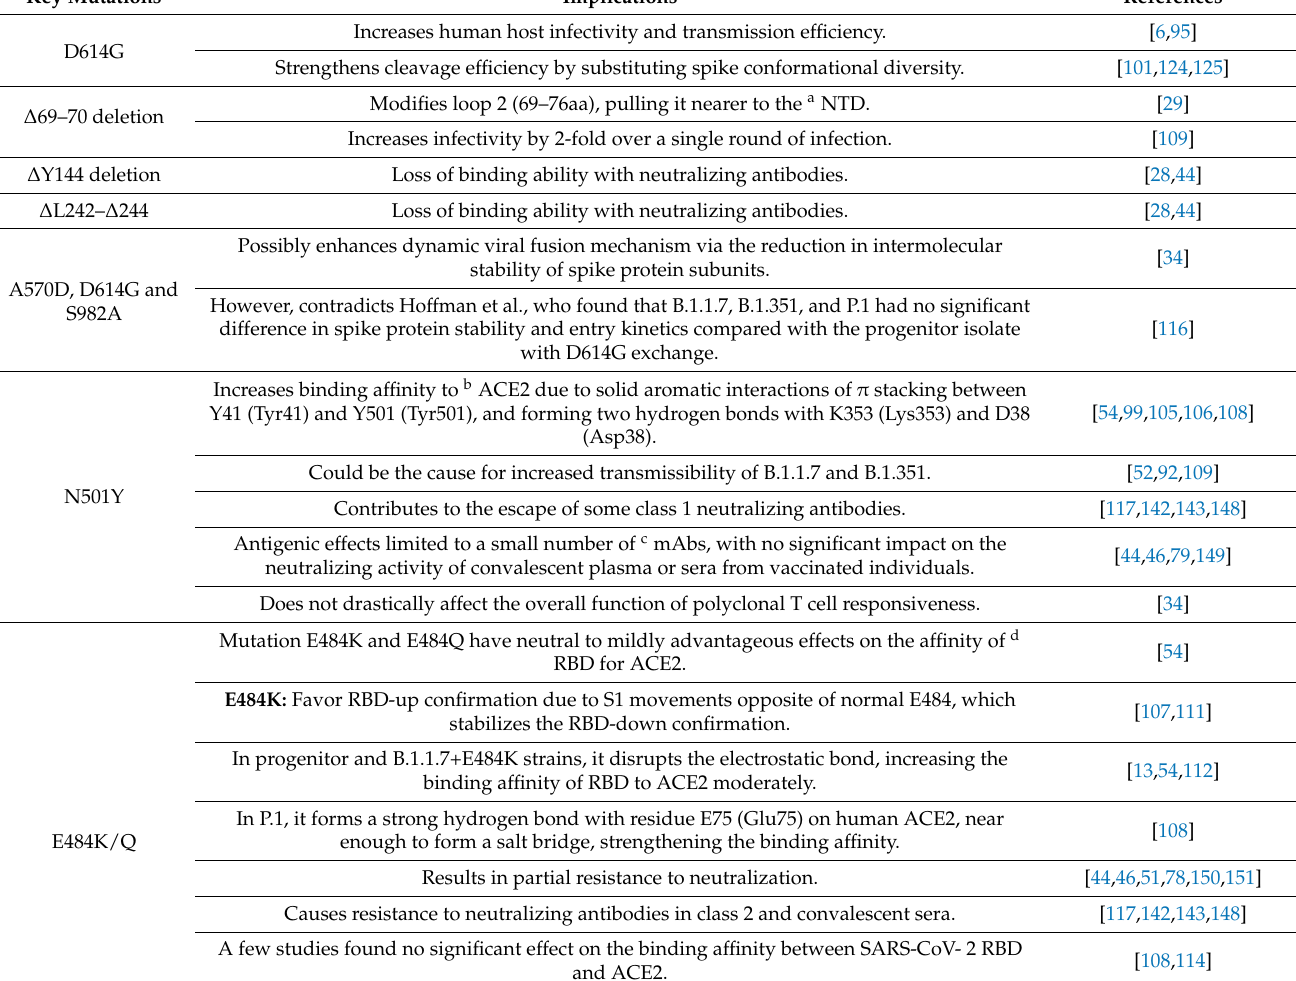
Table 2. Key mutations of VOCs and their